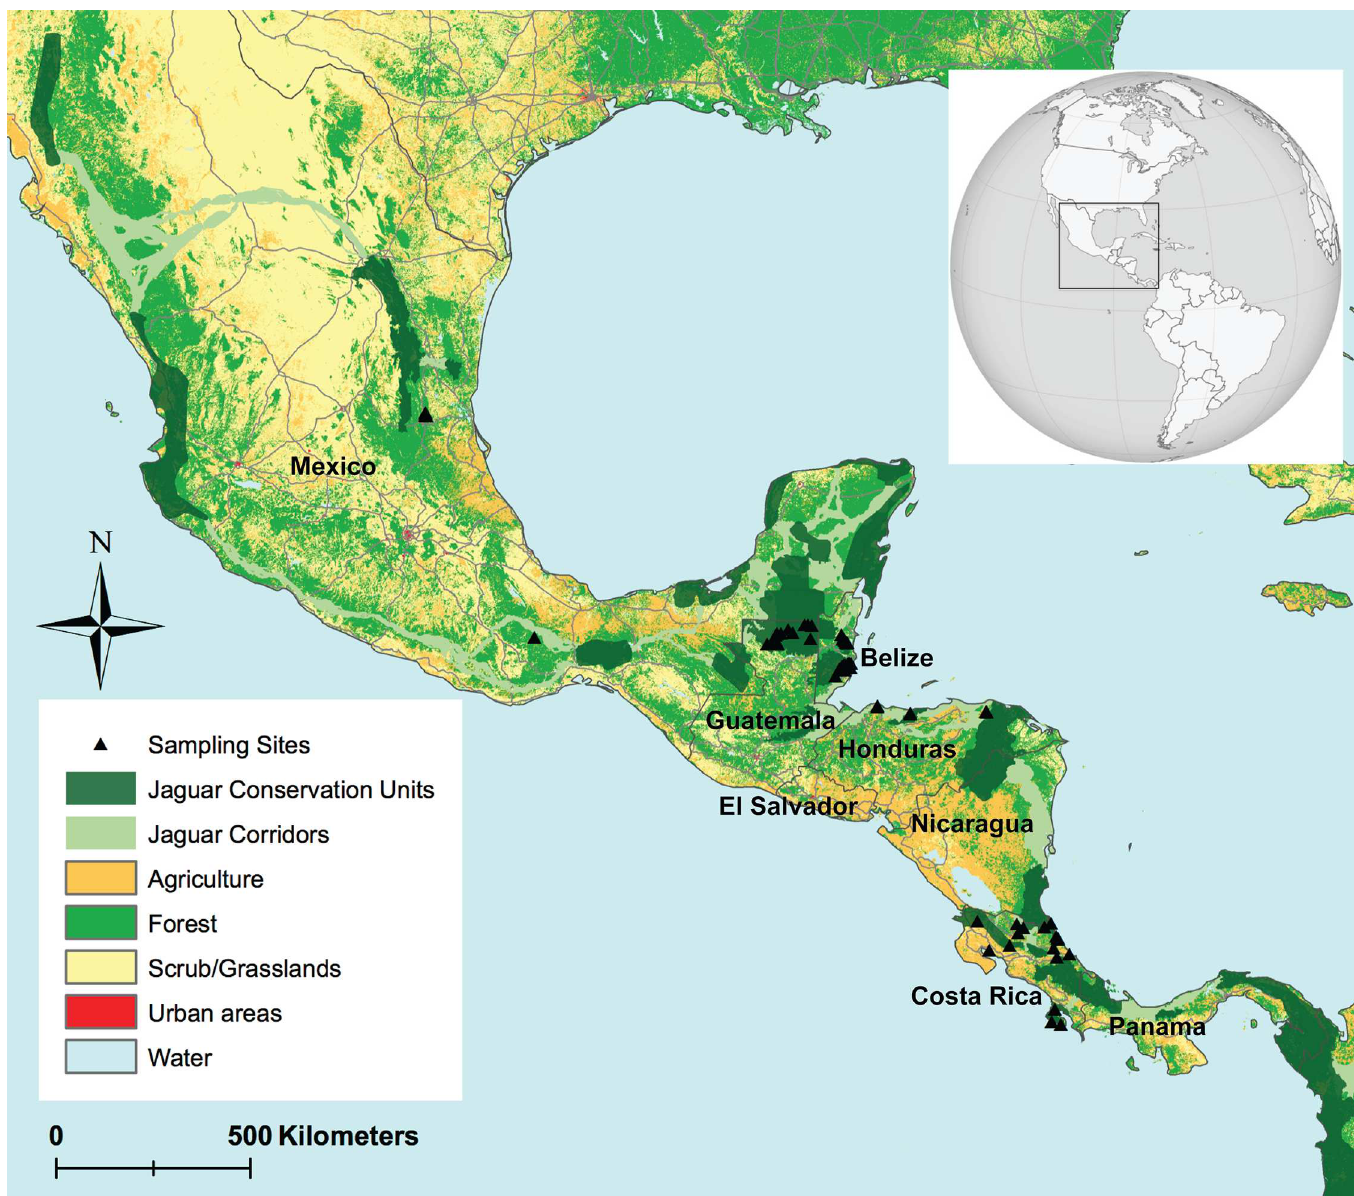
Fig 1. Sampling sites of jaguars across five Mesoamerican countries. Black triangles represent individualjaguar samples collected across five Mesoamerican countries (Mexico, Guatemala, Belize, Honduras, Costa Rica). Spatial data representingjaguar conservation units and movement corridors were obtained from